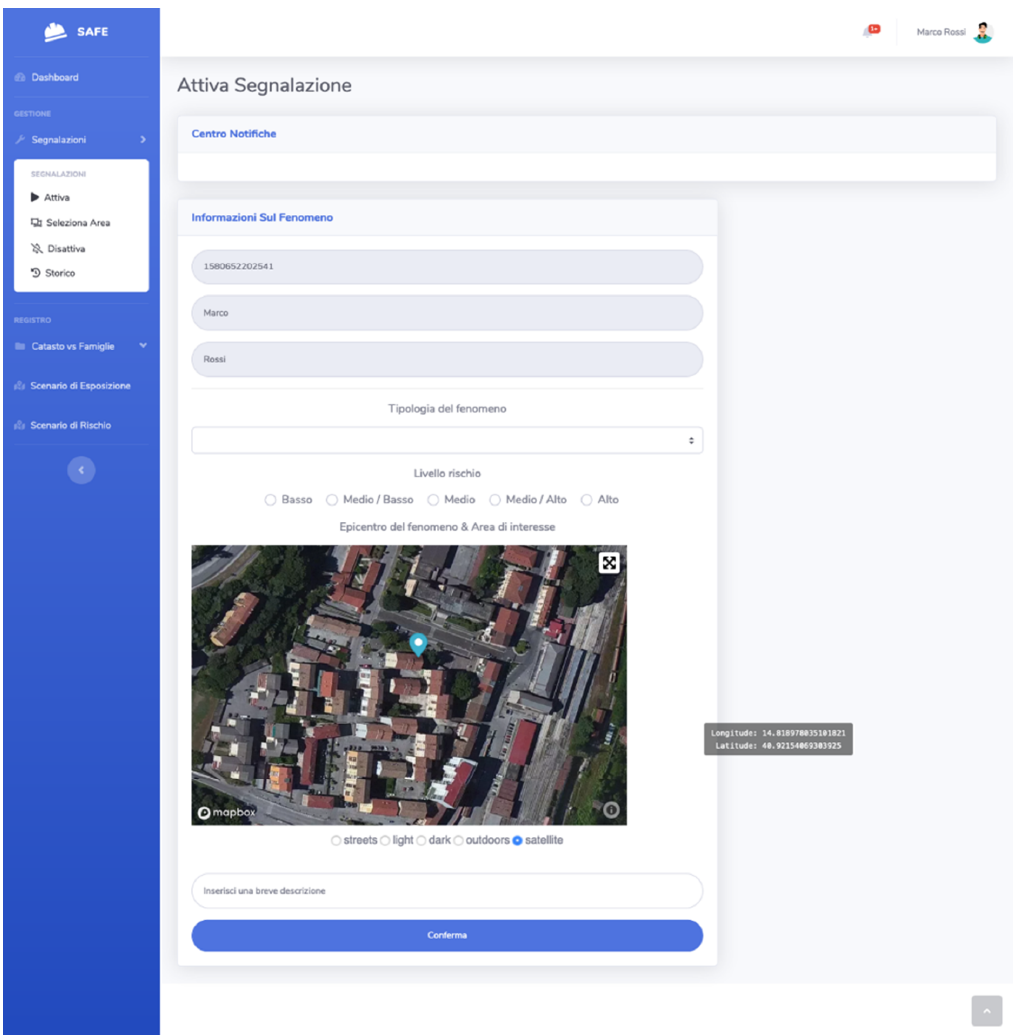
Figure 15. The form to set a new alert located on a building.